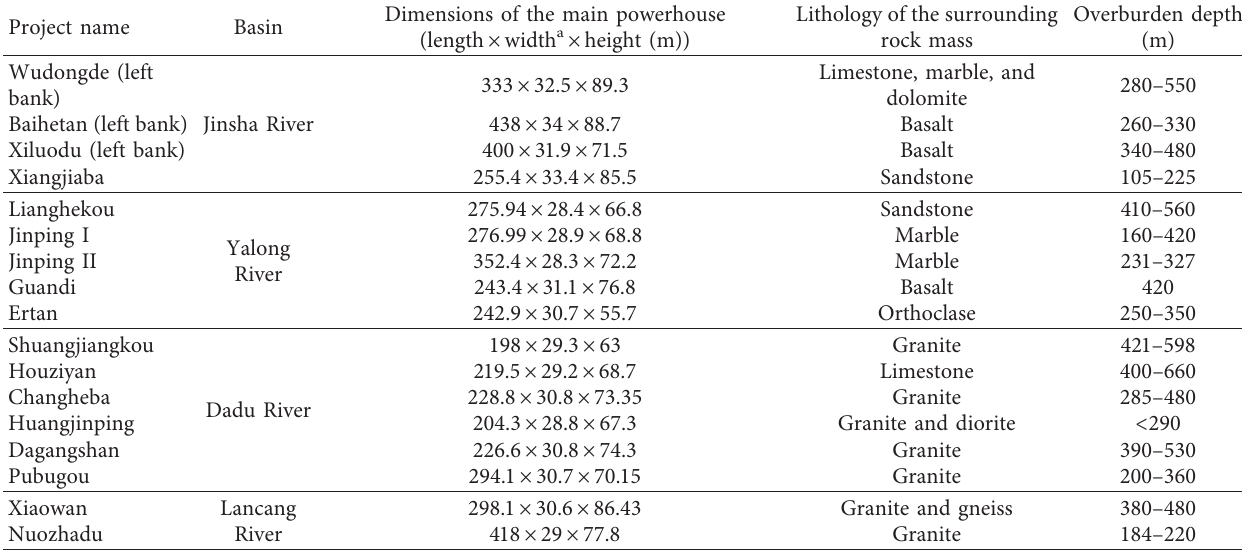
Figure 1: Hydropower stations with large-scale underground powerhouses in southwest China. Table 1: Overview of large-scale underground powerhouses in southwest China